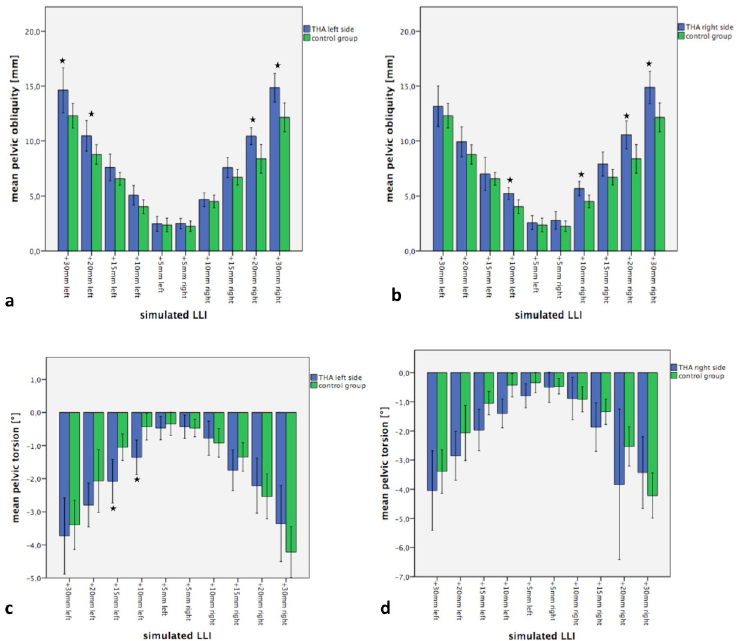
Fig 4. Effects of simulated LLIs on spinal posture of patients with and without THA. a) Changes of lateral deviation in patients after THA of the left side and the control group of healthy subjects. LLIs were simulated on the operated left side and the contralateral side. b) Results for patients after THA of the right side with a corresponding control group. LLIs were simulated on the leg of the THR and the contralateral leg. c) Changes of surface rotation after THA of the left side and control group of healthy subjects. LLIs were simulated on the operated left side and the contralateral side. d) Results for patients after THA of the right side with corresponding control group. LLIs were simulated on the leg of the THR and the contralateral leg. Significant differences are marked with a